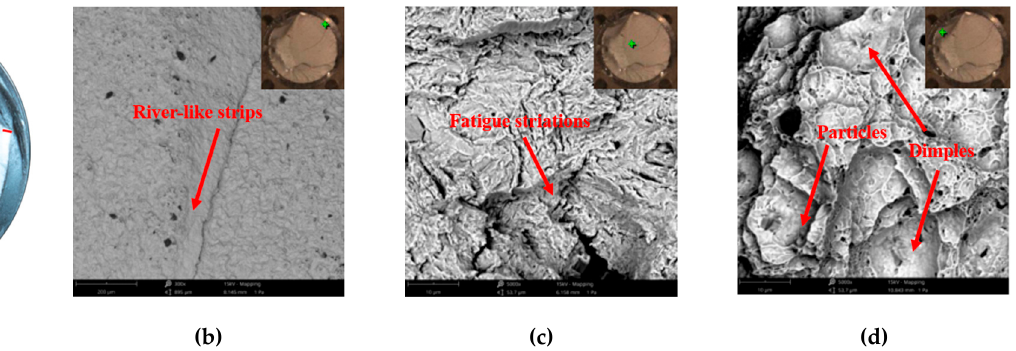
Figure 15. Fatigue macro ‐ fractures of M20 torque ‐ shear HSBs. ( a ) Macro ‐ view fracture. ( b ) 300 times initiation zone. ( c ) 5000 times extension zone. (d) 5000 times fracture zone. initiation zone. ( c ) 5000 times extension zone. ( d ) 5000 times fracture